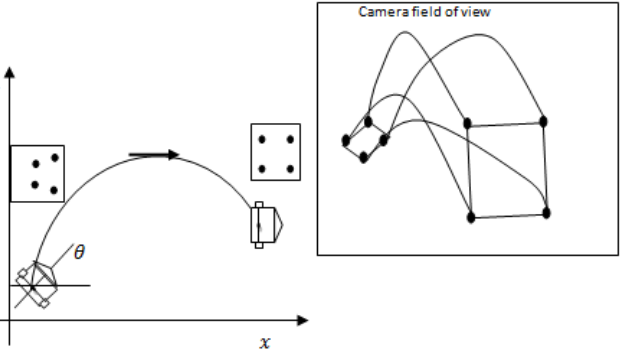
Appl. Sci. 2022 , 12 , x FOR PEER REVIEW Figure 12. Case 1: Where the object does not leave the field of view of the camera.